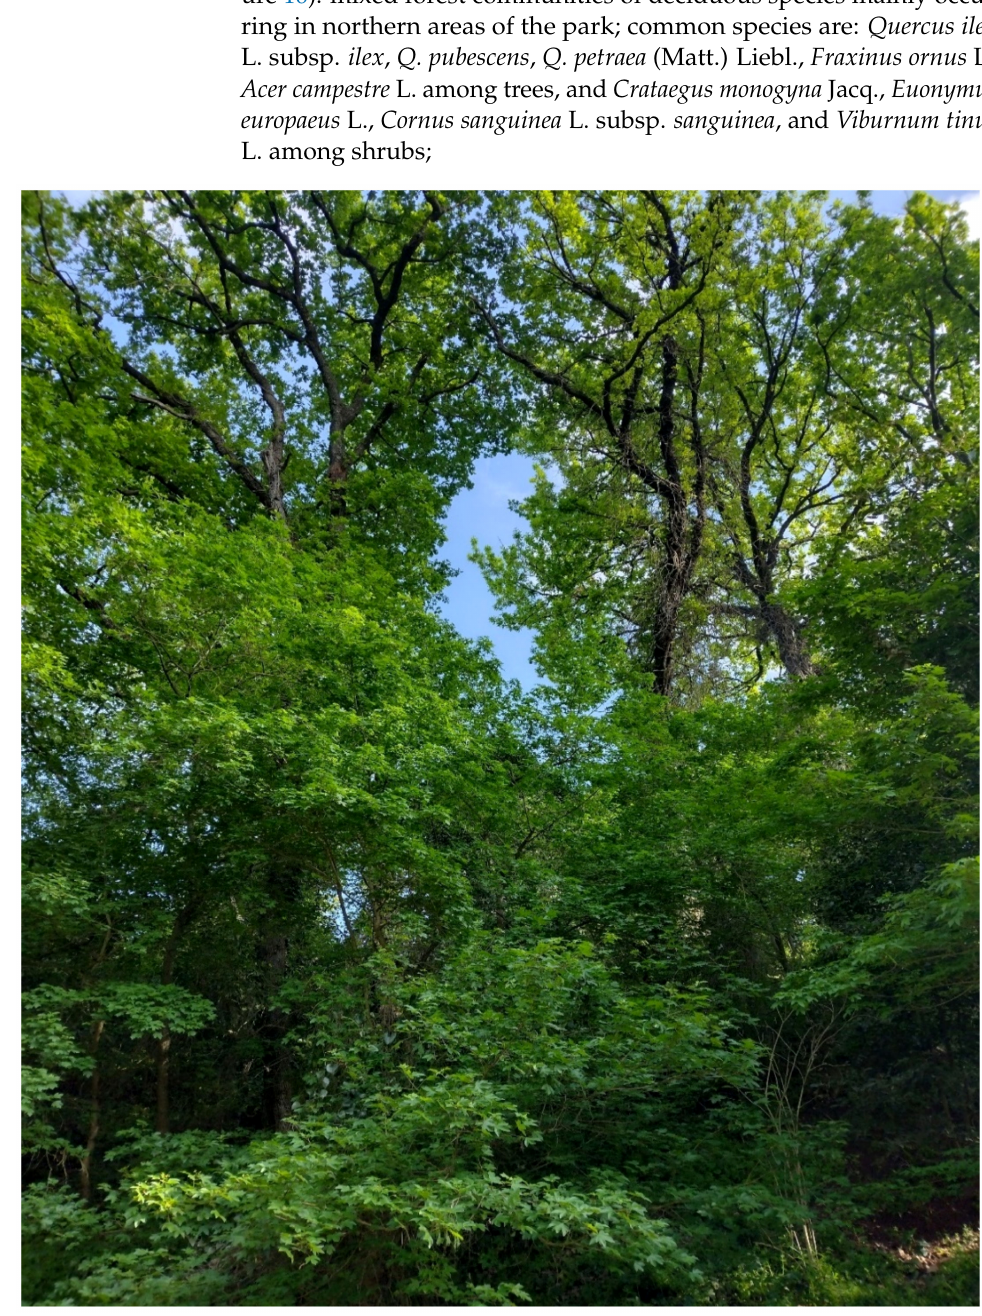
Figure 16. Broad-leaved forests ( Quercetalia pubescenti-petraeae ) in Caffarella